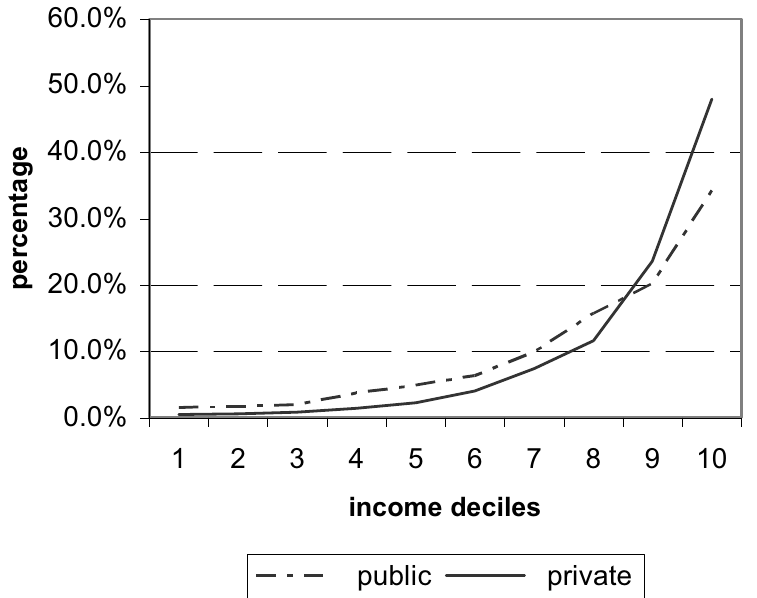
Fig. 2 – Higher education students: public/private enrollment and family income, 2002. Source: IBGE